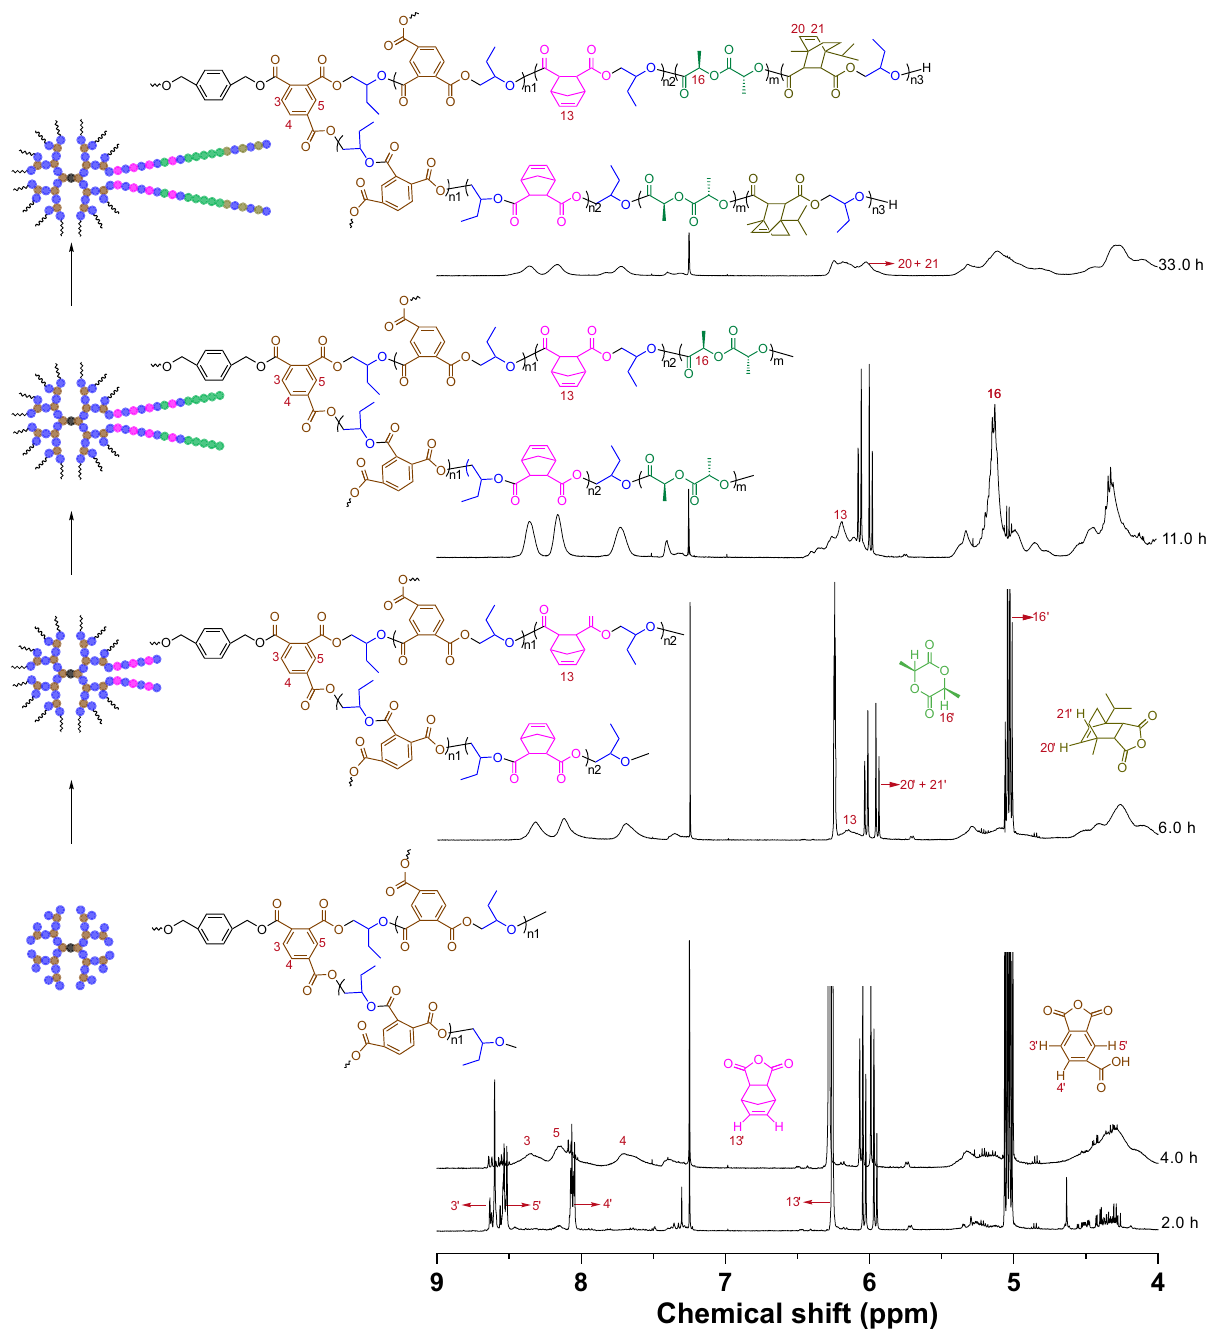
Fig. 7 1 H NMR (CDCl 3 ) spectra of the aliquots withdrawn from the polymerization of mixed TA, NA, L -LA, DPMA, and BO with pivalate cesium as the catalyst and BMD as the initiator at 80 °C. TA trimellitic